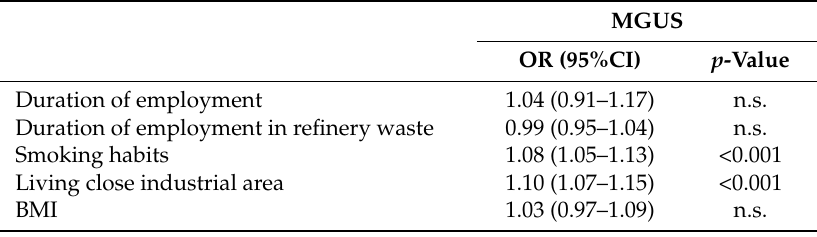
Table 5. The multivariate analysis of MGUS risk